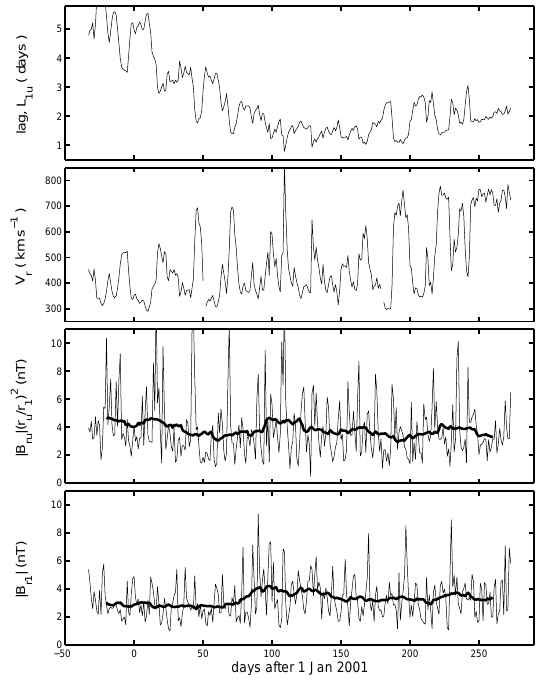
Fig. 10. Same as Fig. 6 for the second perihelion